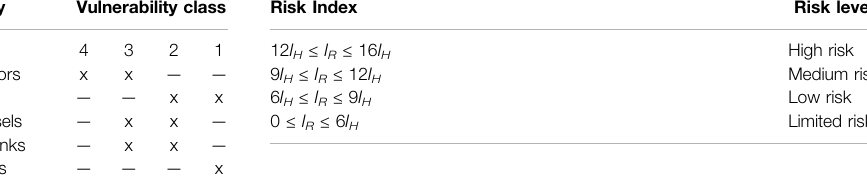
TABLE 1 | Vulnerability classes of process plant equipment.